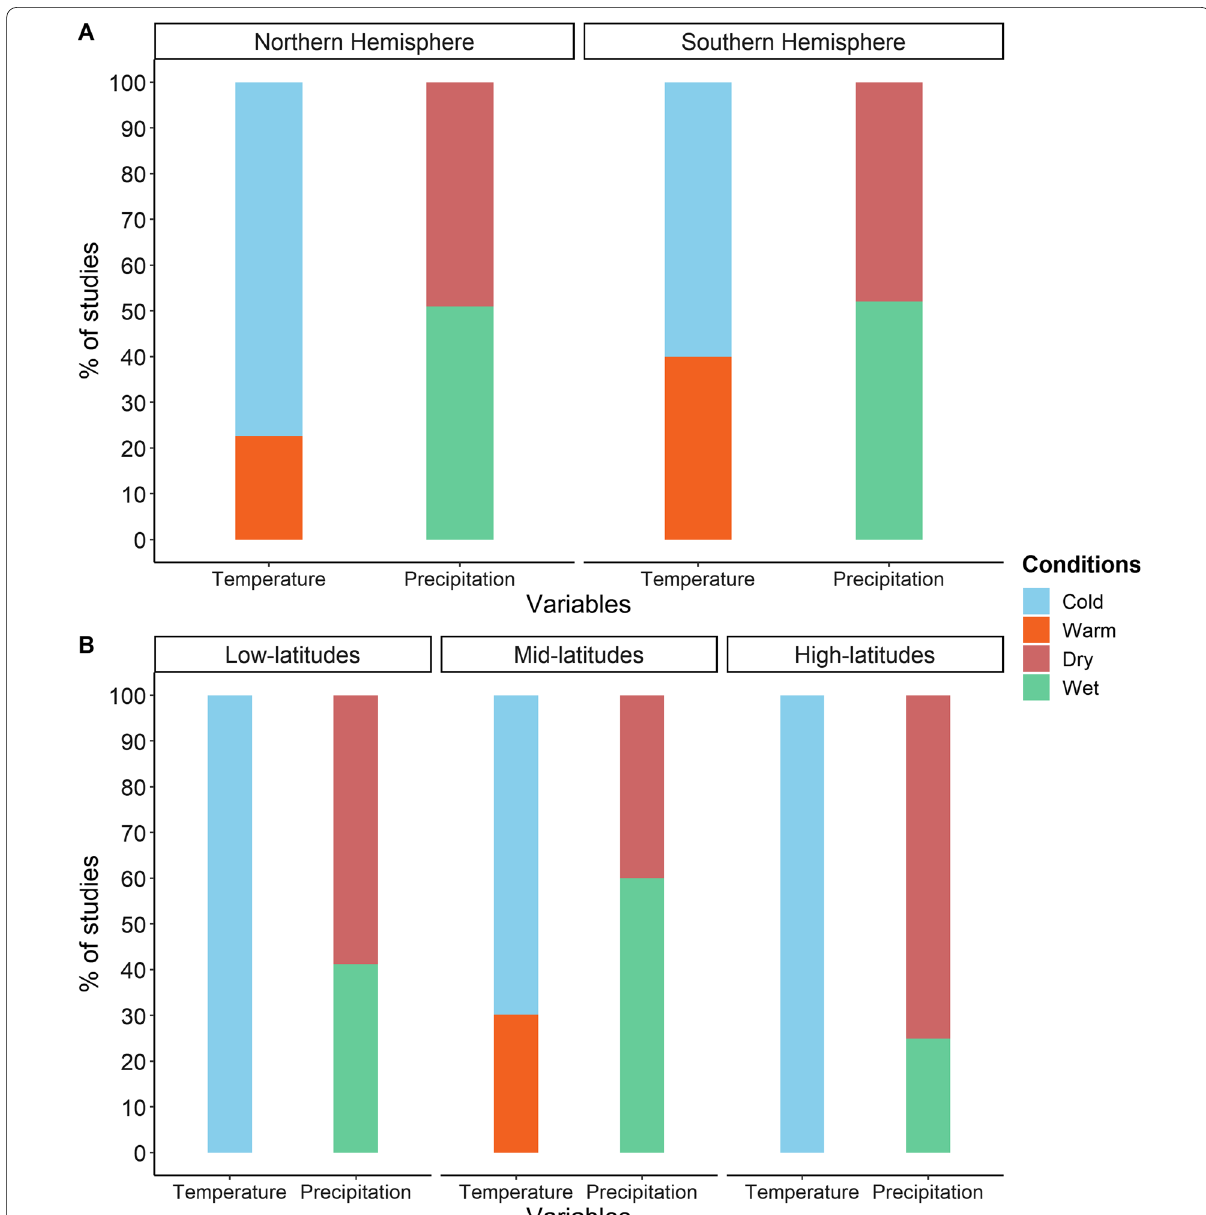
Fig. 11 Relationship of temperature and precipitation during the cold periods (LGM, Heinrich Events, Younger Dryas, 8.2 ka Event, and LIA). A studies over different regions, B studies over the different